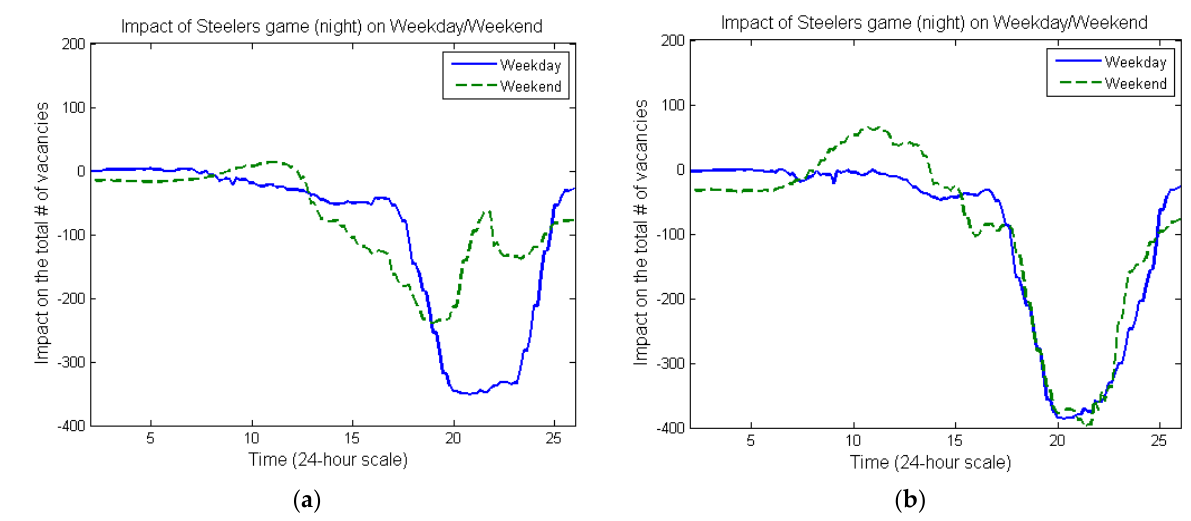
Figure 8. ( a ) Impact of Steelers’ nighttime game with no interaction terms; ( b ) impact of Steelers’ nighttime game with interaction terms.